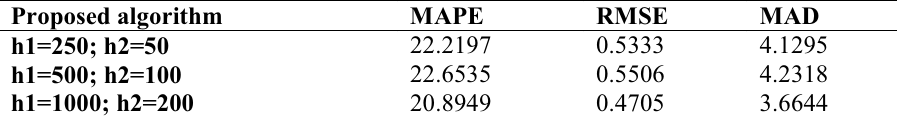
Table 8. MAPE, RMSE and MAD values of various hidden layers in proposed technique for dataset 3 Proposed algorithm